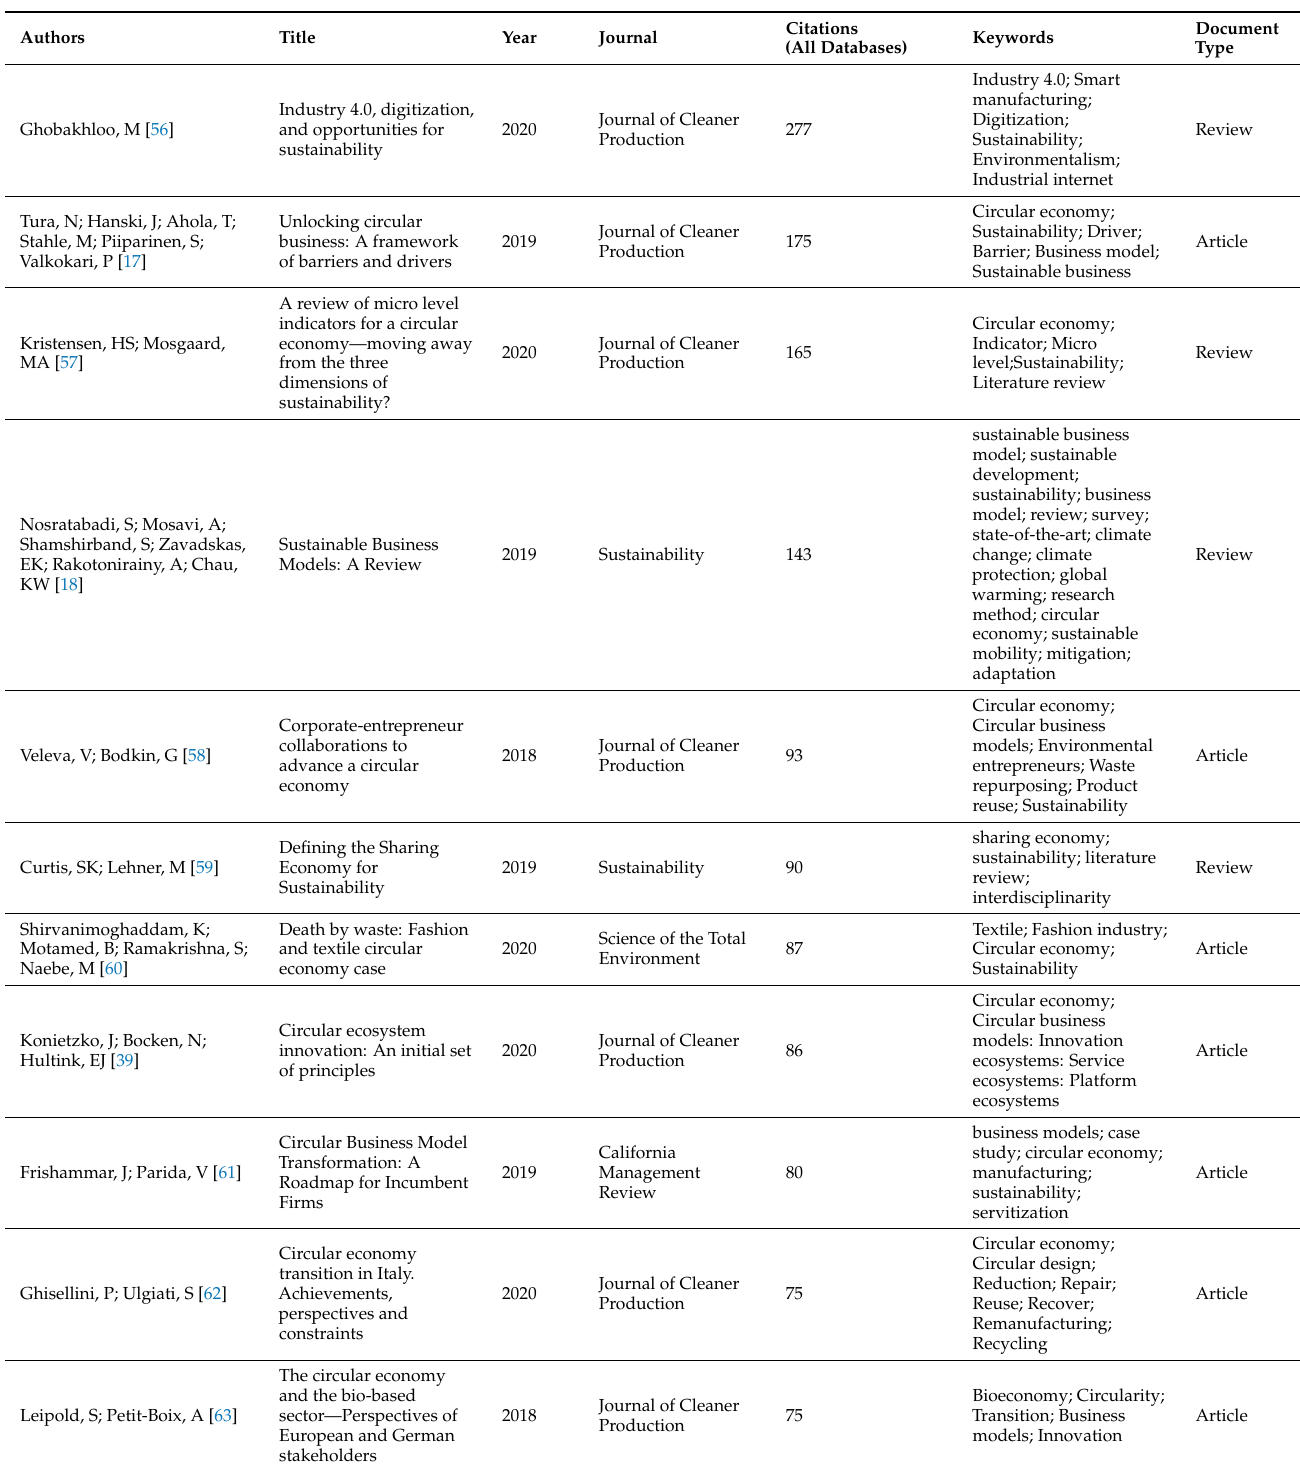
Table 3. Top 11 most cited papers for the combination social